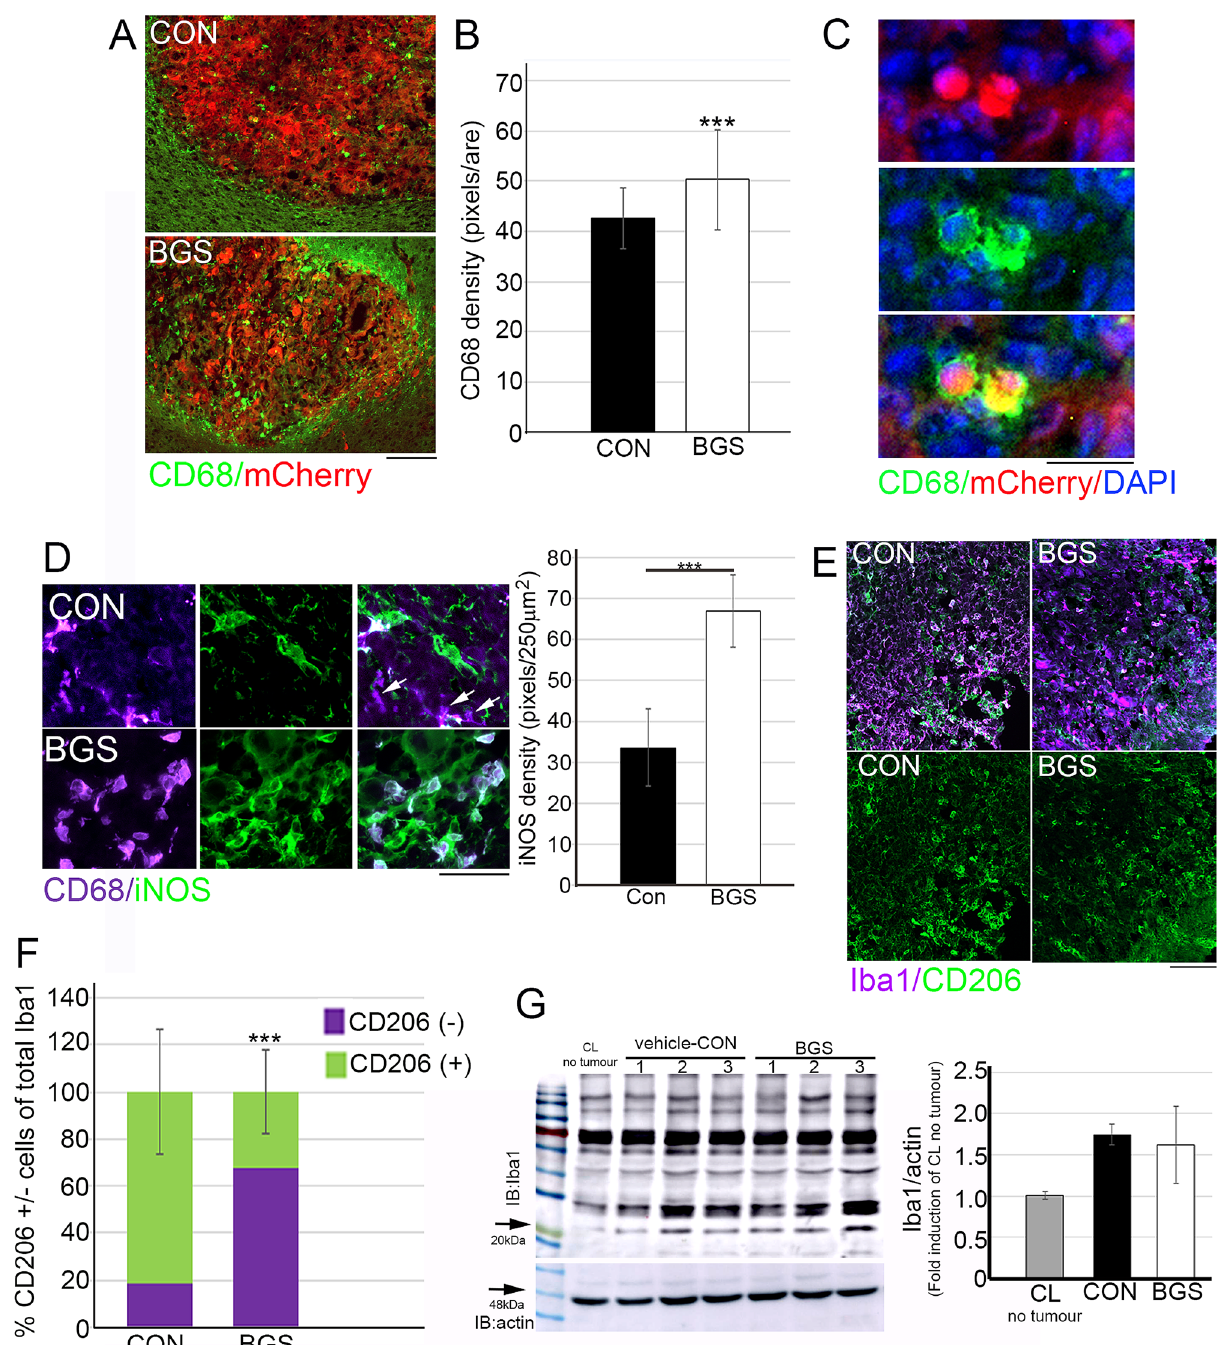
Figure 8. BGS treatment increased CD68 + macrophage intratumor invasion and iNOS recreation. ( A ) Representative images of the control and BGS treatments for CD68 + macrophage invasion into the tumor (mCherry), scale bar 200 µm. ( B ) CD68 + cell density is significantly increased in the BGS-treated group compared to the control group. Results are presented as mean ± STDEV (n = 7 animals/group; ***p < 0.001). ( C ) An example of CD68 + cell phagocyte mCherry positive RET melanoma cells, scale bar 25 µm. ( D ) Double immunostaining of CD68 + with iNOS demonstrated that in the BGS treatment group most CD68 + cells were co-labeled with iNOS as opposed to the control group where significantly less iNOS expression was detected on the CD68 + cells and overall. Results are presented as mean ± SD (n = 7 animals/group; ***p < 0.001). Scale bar 50 µm. ( E ) Double immunostaining of CD206 and IBA-1 demonstrated that in the BGS treated group significantly lower number of CD206 + IBA1 + cells as opposed to the control group where significantly higher number CD206 expression was detected on the Iba1 expressing cells. ( F ) Results are presented as mean ± SD (n = 5 animals/ group; ***p < 0.001). Scale bar 100 µm. ( G ) Tumour lysates from (n = 5 animals/group) were immunoblotted with Iba1 and actin Abs in order to demonstrated that Iba1 levels were no different between BGS treated compared to vehicle-control. Results are presented as mean ±